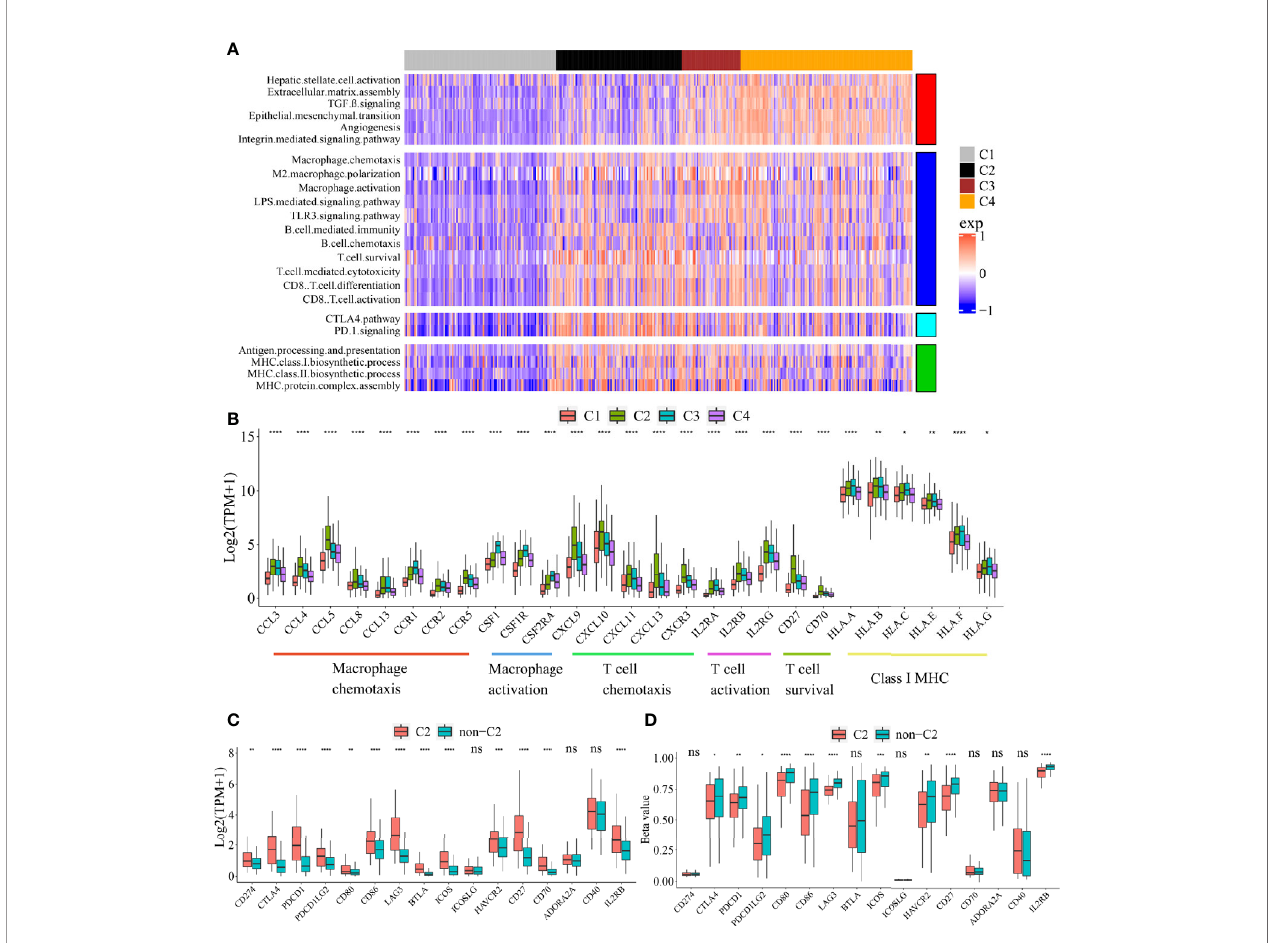
FIGURE 2 | Functional characteristics of four immune subclasses. (A) Heatmap of GSVA scores for indicated functional signatures. Color scale: GSVA score from − 1 (blue) to +1(red). (B) Boxplot plot of the expression levels for selected immune-related pathways. (One-way ANOVA test). Boxplot of the expression (C) and methylation (D) levels of immune checkpoint-related genes between C2 and non-C2 subclass. (Student ’ s t test). All P values labels: ns P > 0.05, *P < 0.05, **P < 0.01, ***P < 0.001, ****P < 0.0001). Error bars are presented as the standard deviation